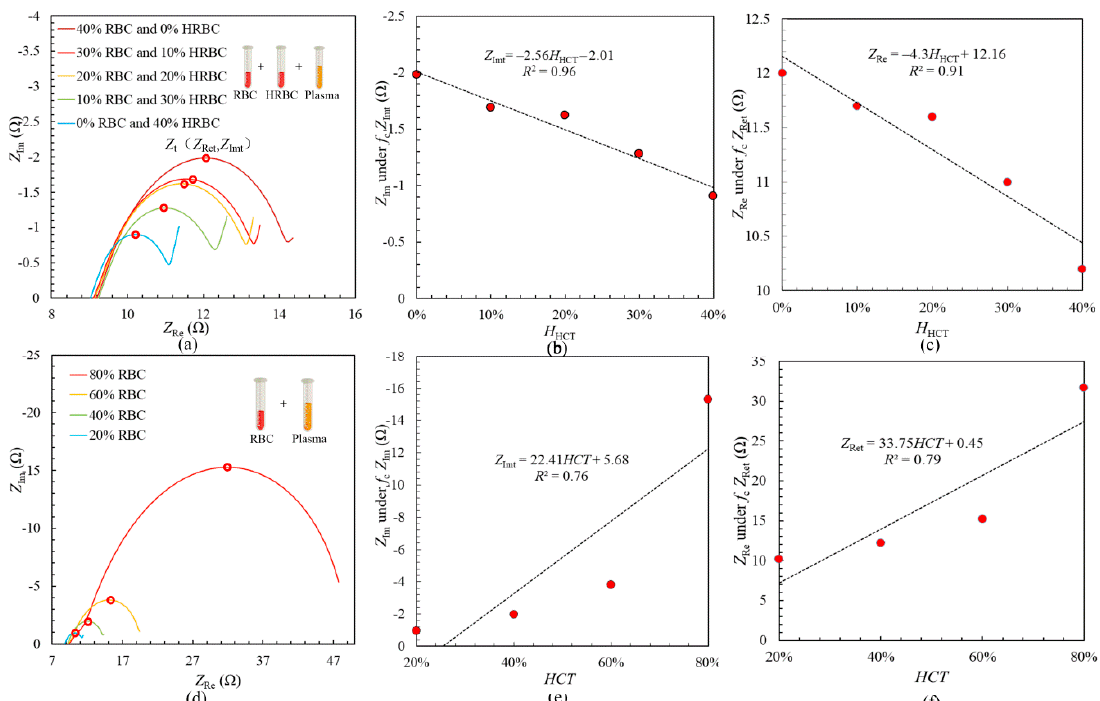
Figure 2. ( a ) The Nyquist plots of the blood with different HCT and H HCT ; ( b ) Relationship between H HCT and Z Imt ; ( c ) Relationship between H HCT and Z Ret ; ( d ) The Nyquist plots of the blood with different HCT ; ( e ) Relationship between HCT and Z Imt ; ( f ) Relationship between HCT and Z Ret .